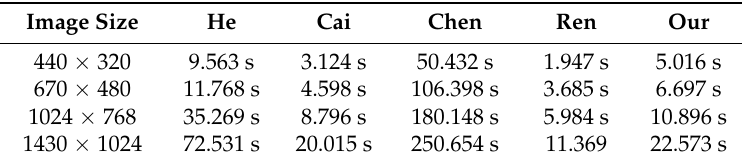
Table 4. The execution time of different size of